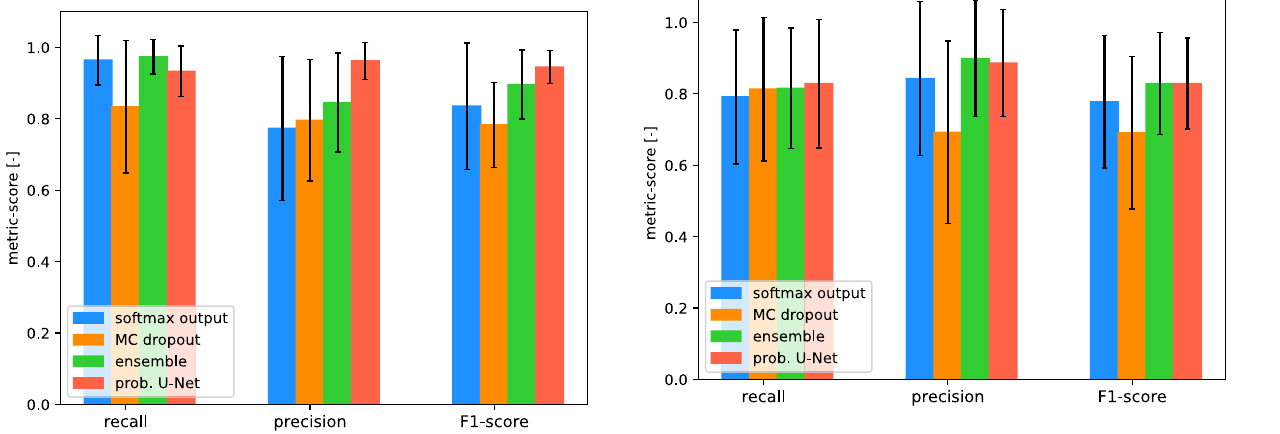
Fig. 10 Metric-scores for the dataset 1 with the round defects